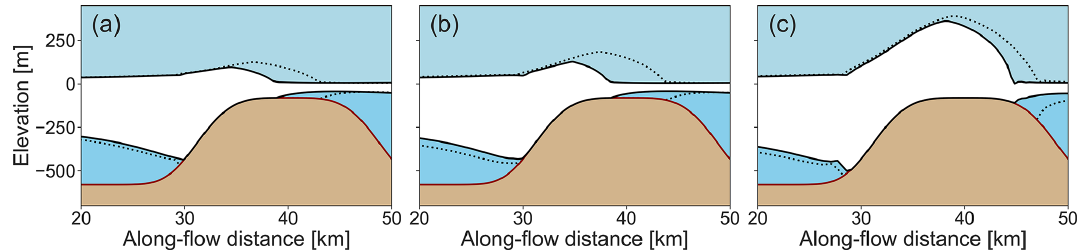
Figure 11. The figures show a cross-section of the ice rises in the along-flow direction for (a) the low-, (b) the intermediate-, and (c) the high-basal-friction scenario. The dotted lines show the geometry of the ice rises before sea level perturbation, and the solid lines show the geometry after a full cycle of sea level increase and